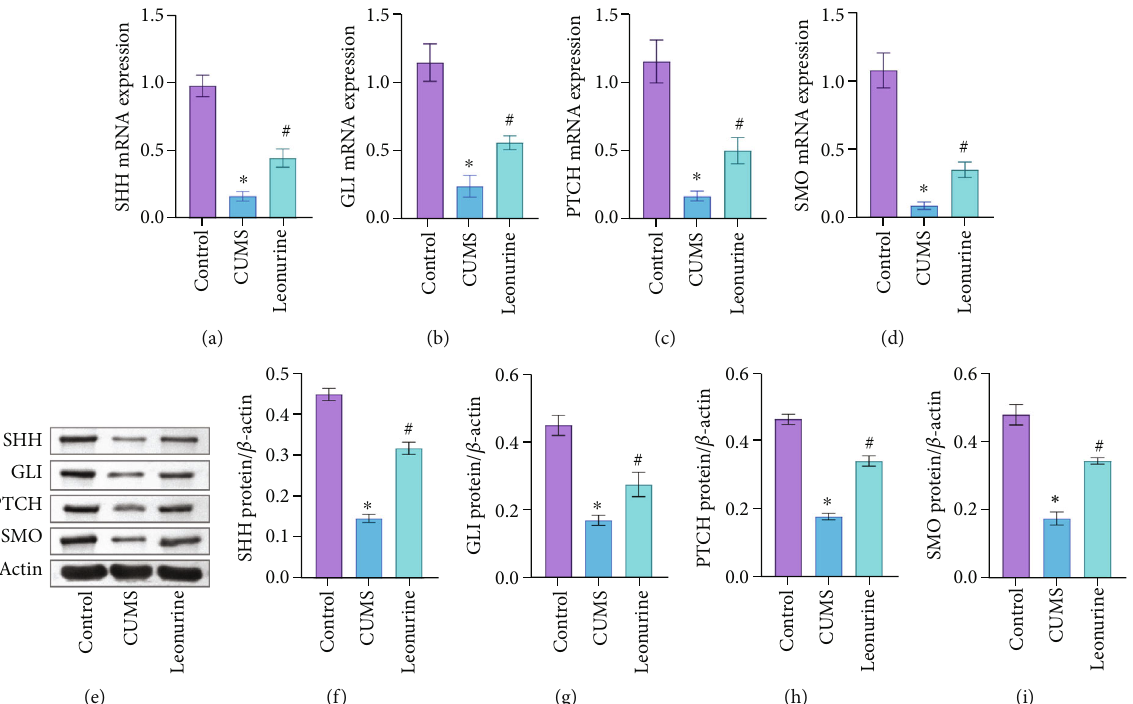
Figure 2: The e ff ects of leonurine on the SHH/GLI signaling pathway. (a – i) SHH, GLI, PTCH, and SMO expressions in the